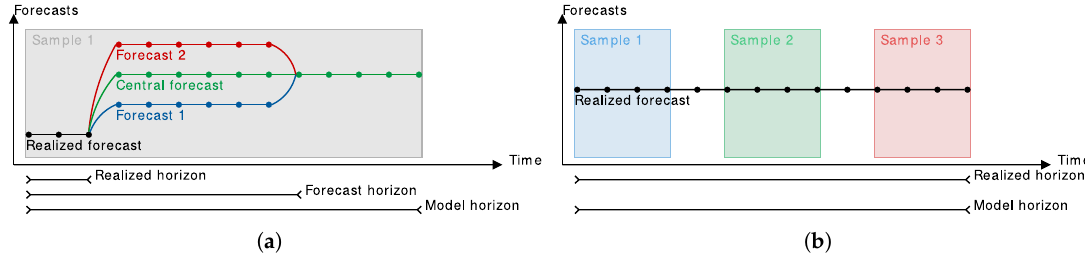
Figure 3. Stochastic structures: ( a ) a multi-forecast structure used by the scheduling model and ( b ) a multi-sample structure used by the investment